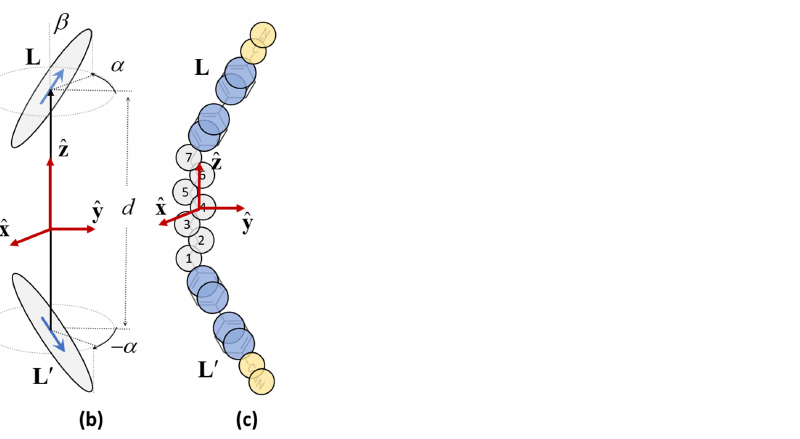
where Z is the unit vector along the modulation direction ( Z axis), m is the polar director (local C 2 axis of the phase), y is the molecular C 2 axis and z is the molecular axis along the line connecting the centers of the two mesogenic units of the molecule (Figure 4b). Note that the scale of the modulation wave number k is set by the intramolecular distance d . For reasonable bend-angles β (0 to π /4), the model yields up to 3 positionally disordered fluid phases, the isotropic ( I ) fluid, the uniaxial nematic ( N U ) and the so called